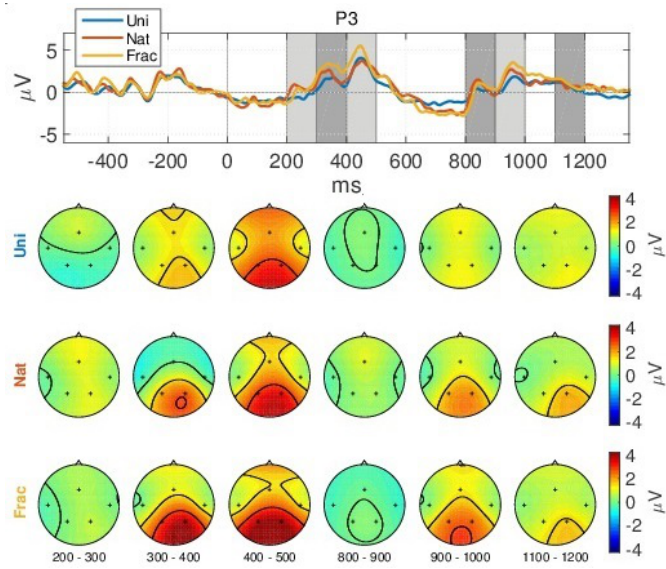
Figure 5. Grand Average (GA) Event Related Potential (ERP) and scalp topographies over all blocks for channel P3. The scalp topographies relate to the temporal intervals shaded in grey.